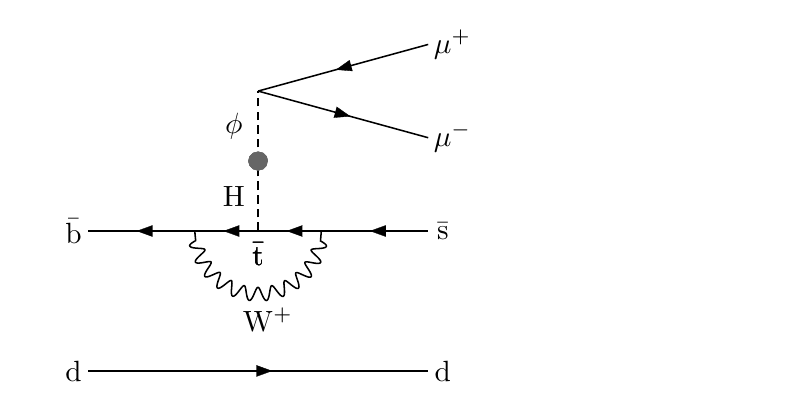
Figure 1 . Diagrams illustrating an SM-like Higgs boson ( H ) decay to four leptons ( ‘ ) via two intermediate dark photons, Z [6]: (left) through the hypercharge portal; (right) through the Higgs D portal, via a dark Higgs boson ( H ). D